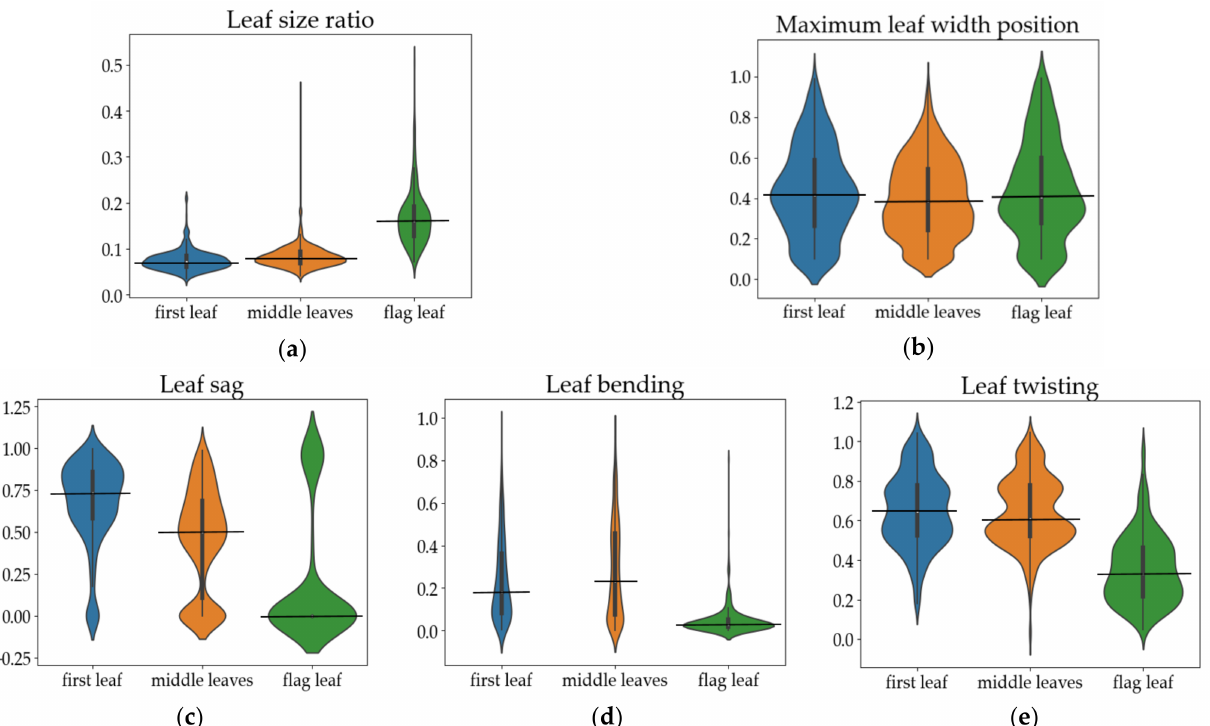
Figure 7. Distribution of the five morphological leaf parameters at different leaf positions. ( a )–( e ) are the leaf features distribution of leaf size ratio, maximum leaf width position, leaf sag, leaf bending, and leaf twisting, respectively.